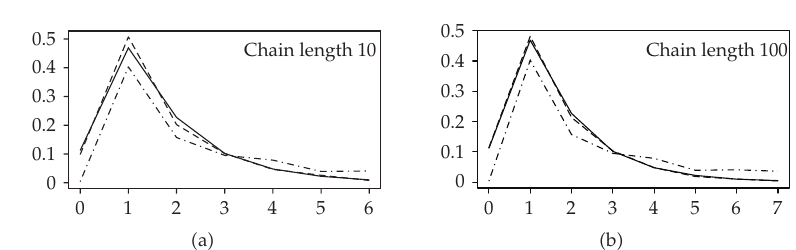
Figure 1: Shown is the distribution of vertex degrees of 50 simulated networks (cid:2) solid (cid:3) and that of numbers simulated from the corresponding Markov chain (cid:2) dashed (cid:3) , using parameters estimated for the P. falciparum dataset. In addition, the observed degree distribution for P. falciparum is shown (cid:2) dot-dashed (cid:3)